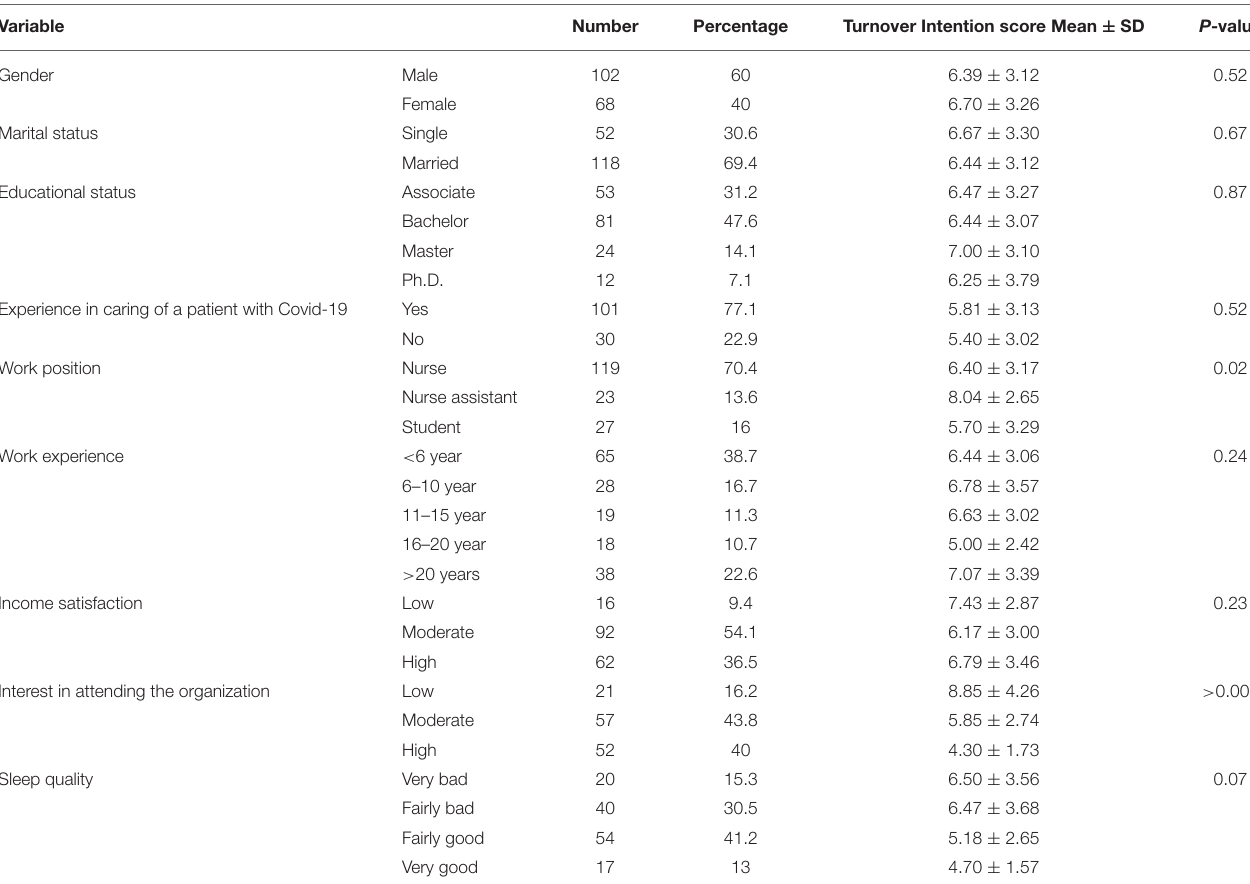
TABLE 1 | Socio-demographic information of participants.